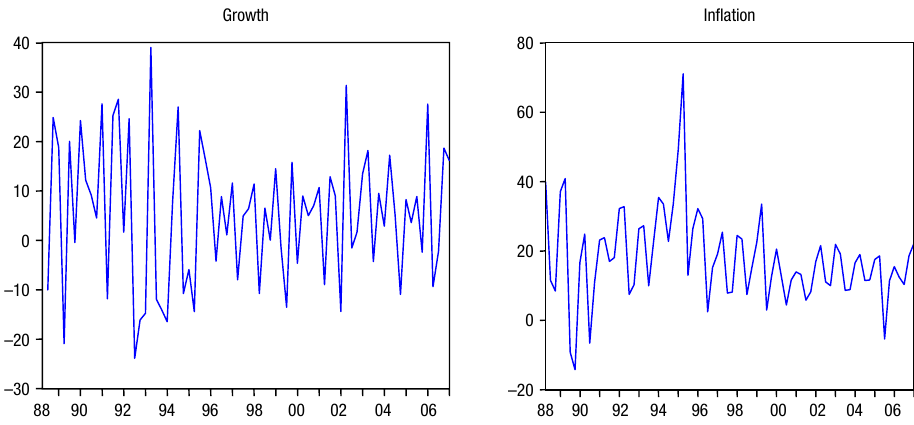
Fig. 1. Inflation and Growth Rate in the Iranian